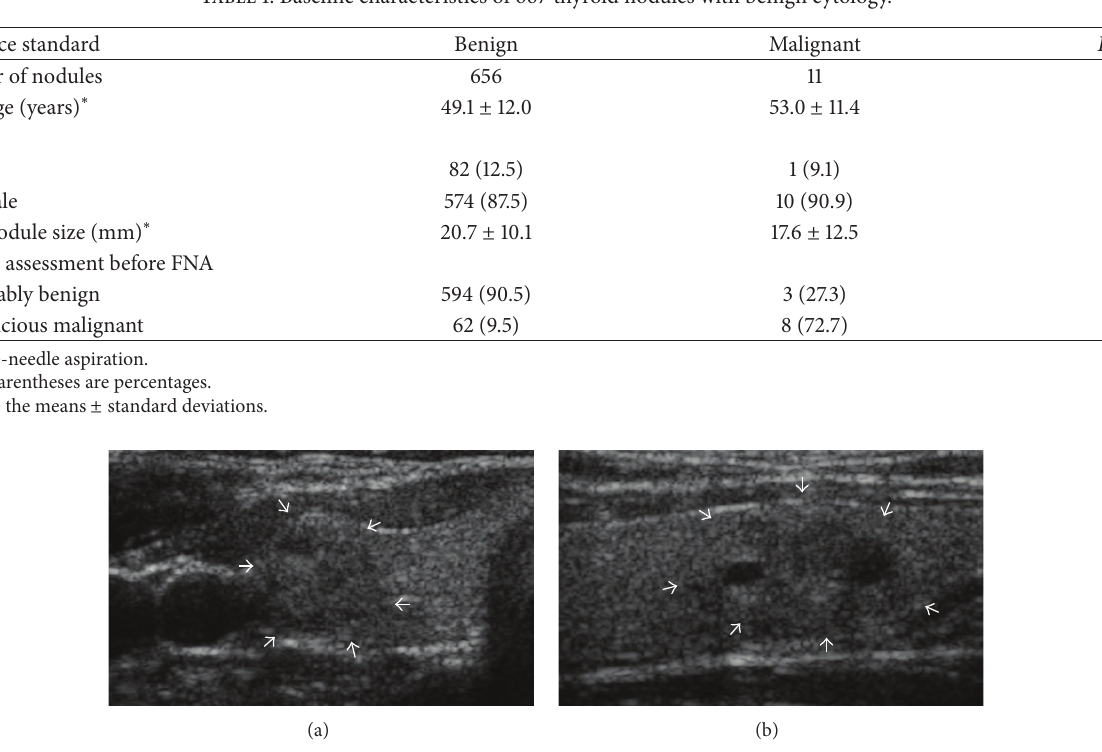
Figure 2: Initially suspicious but concordant nodule after imaging-cytology correlation. US scans ((a) transverse; (b) longitudinal) in a 41- year-old female without remarkable medical history show a 16mm sized predominantly solid mass (arrows) with microlobulated margin in the lower pole of the right lobe of the thyroid gland. The nodule was taller than wider on transverse scan. The initial cytologic result was adenomatous hyperplasia which was concordant with US findings considering relatively low PPV of these US finding in imaging-cytology correlation after biopsy. A follow-up US was recommended and nodule size gradually decreased from 16 mm to 13mm with decrease of the cystic portion in follow-up US evaluations until July 2013 without any other significant changes in US features.